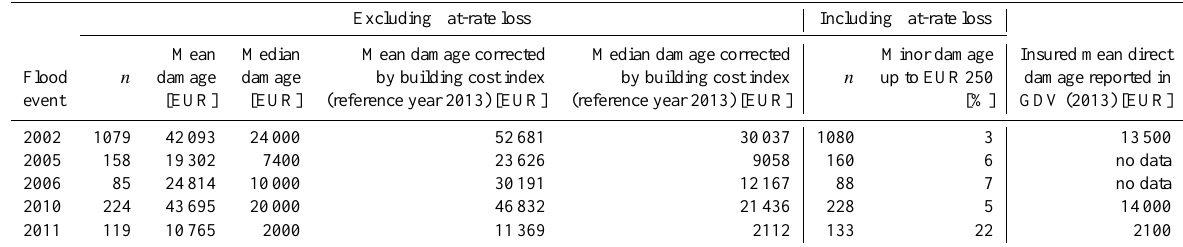
Table 9. Flood damage of buildings.